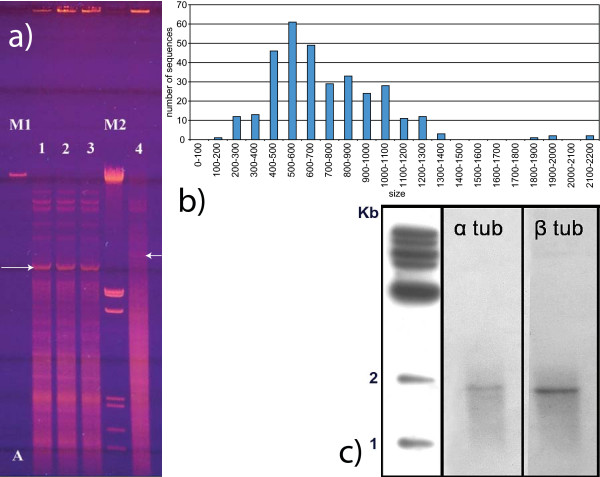
a) Structure of N. ovalis macronuclear chromosomes. 1a-0.4% Agarose gel: M1 = λ- DNA (48502 bp). M2 = λ Eco RI/HindIII (sizes of the DNA fragments: 21226, 5148+4973, 4268, 3530, 2027, 1904, 1584 and 1375 bp). Lane 1,2 and 3 contain total DNA of Nyctotherus ovalis. Lane 4 contains total DNA of Euplotes crassus. Arrows indicate the ribosomal clusters (see Materials). b) Length distribution of the sequenced full-length macronuclear chromosomes. c) Southern blotting: unrestricted total DNA of N. ovalis was separated on a 0.7% agarose gel, blotted and hybridized with clones containing the α2 tubulin (α tub) and the β2 tubulin gene of Stylonychia lemnae. The labeling of single, gene-sized bands indicates the presence of tubulin genes on gene-sized DNA molecules.